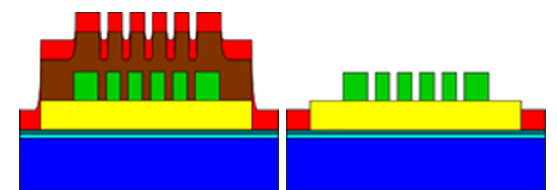
Figure 4. Cross section of the detector chip before (left) and after (right) the lift-off process of aluminum contacts (Kallis et al., 2014).